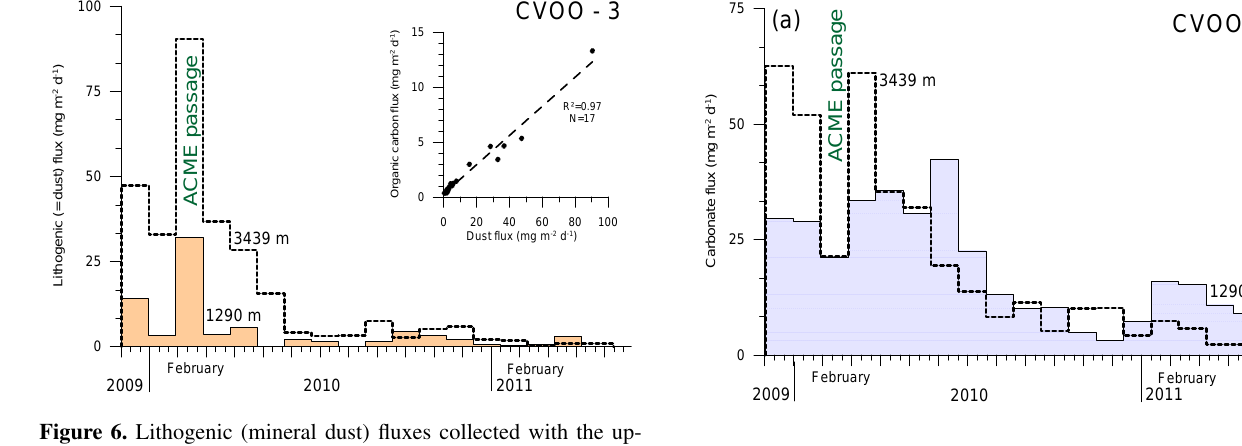
Figure 6. Lithogenic (mineral dust) fluxes collected with the up- per and lower sediment traps at CVOO-3. Upper and lower trap fluxes correspond well ( r 2 = 0.83, N = 17), but fluxes in the deep trap were more than twice as high compared to the upper trap dur- ing winter–spring when the ACME passed. Note the very close re- lationship with organic carbon ( r 2 = 0.97, N = 17) shown for the deep trap samples (insert).